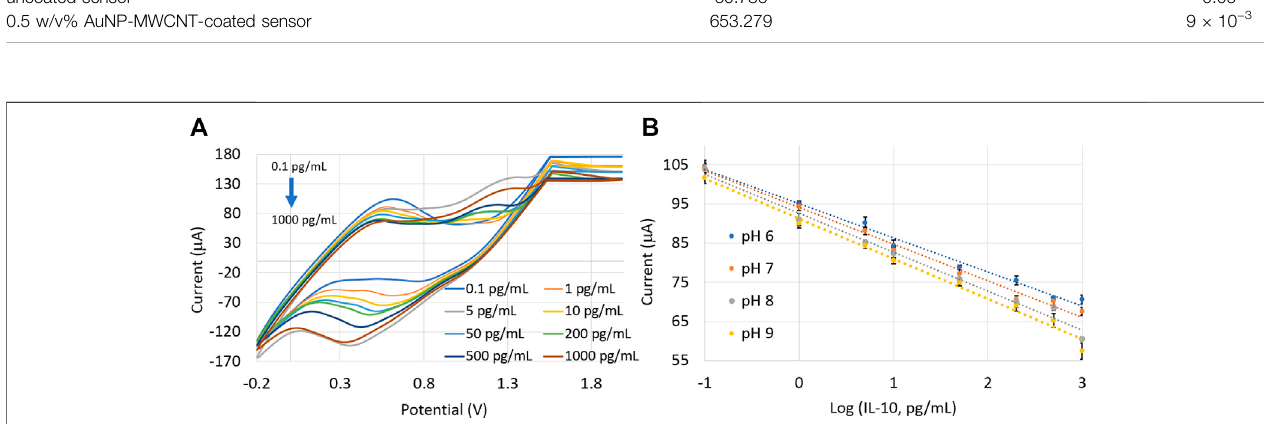
FIGURE6|(A) CVplotsfromthe0.5%(w/v)AuNP-MWCNT-coatedIL-10sensorinapH=7solution. (B) CalibrationplotsinSWFsolutionswithvaryingpH(=6,7, 8, and 9). Error bars represent three repeated measurements for each protein